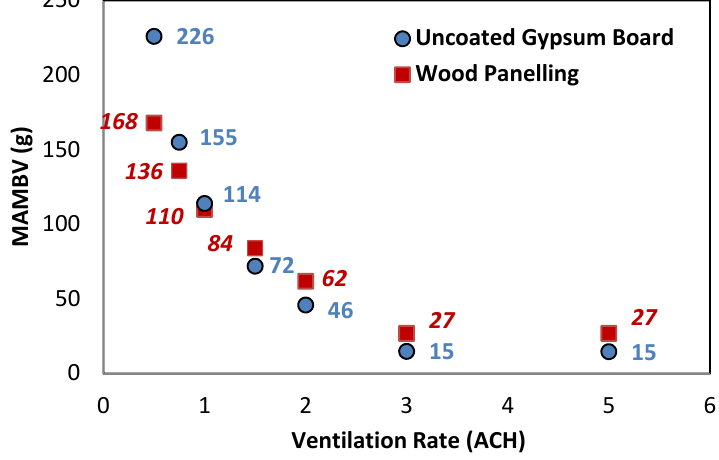
Figure 4. Maximum accumulated moisture buffering value (MAMBV) at different ventilation rates for uncoated gypsum board and wood paneling under supply air humidity at 4.7 g/kg (cases 1, 22,